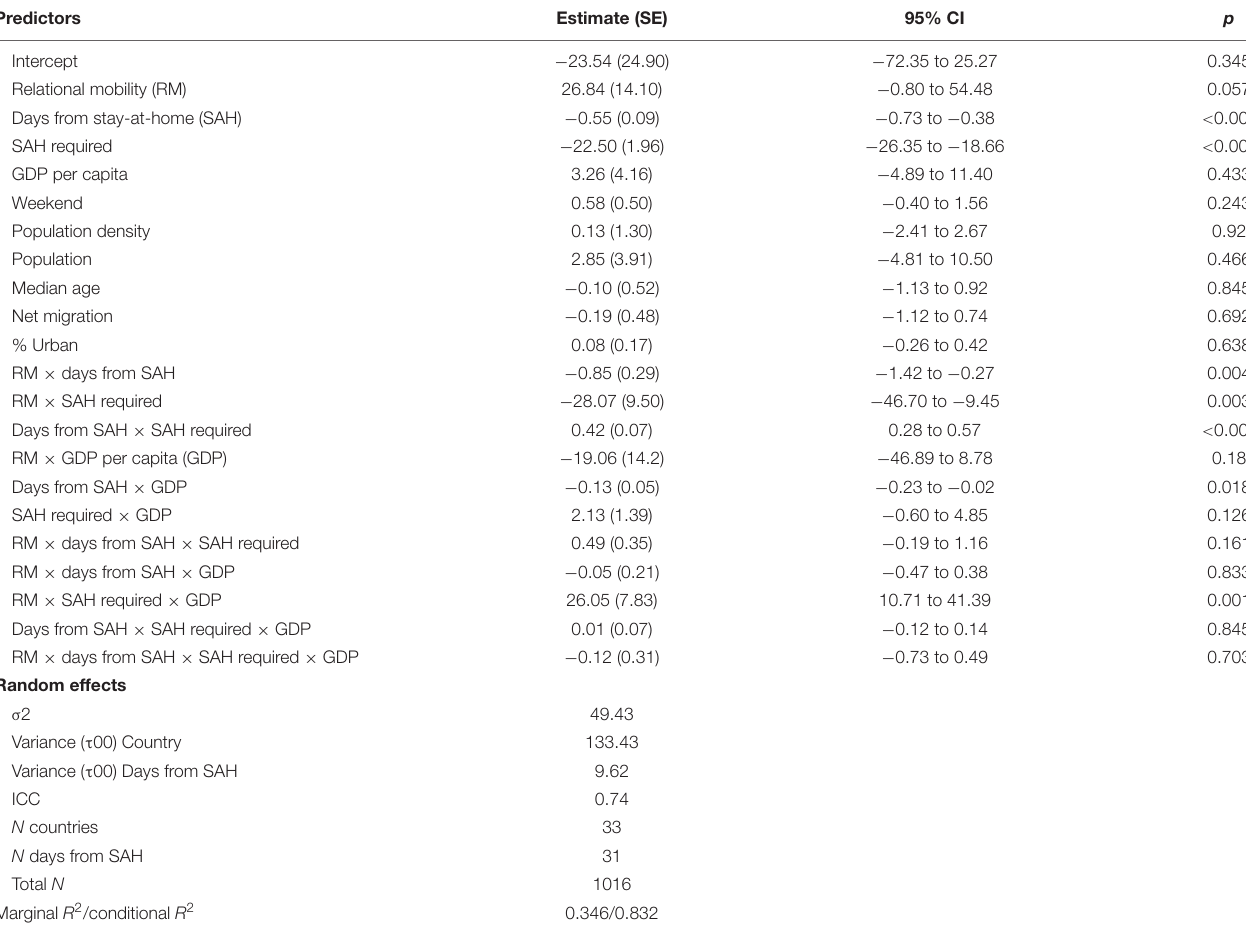
TABLE 2 | The impact of relational mobility and GDP per capita on geographic mobility after the issuance of stay-at-home (SAH) orders. Predictors Estimate